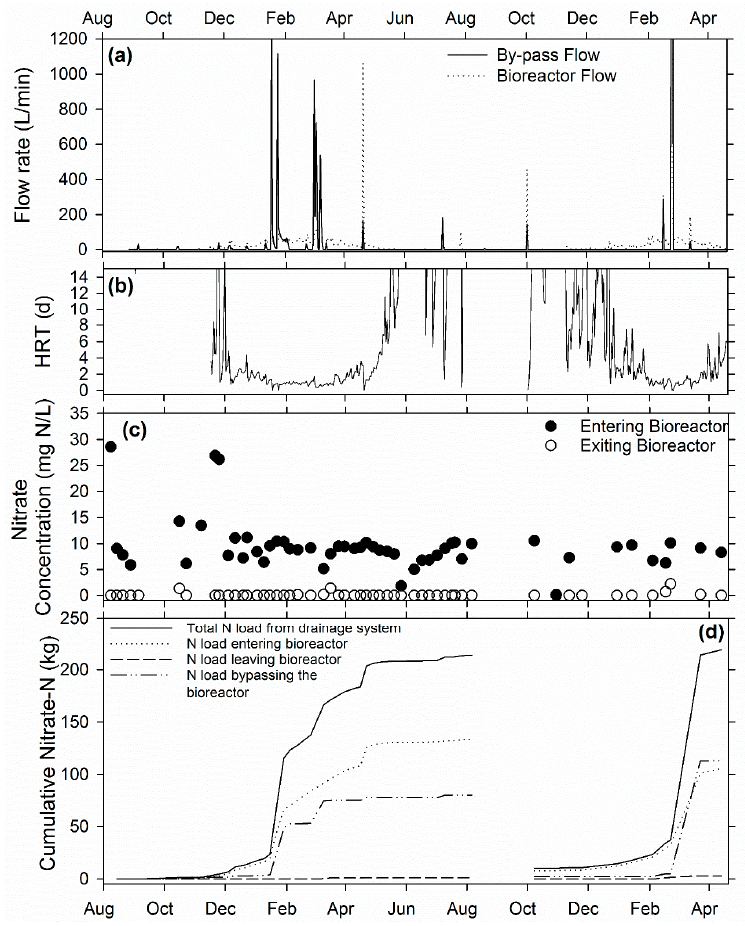
Figure 6. Queen Anne Farm bioreactor and ( a ) bypass flow rate; ( b ) hydraulic retention time, inflow; and ( c ) outflow nitrate concentrations; and ( d ) nitrate loadings from August 2014 to mid-April 2016. Loadings reflect the annual period from the beginning of monitoring to August 2015.